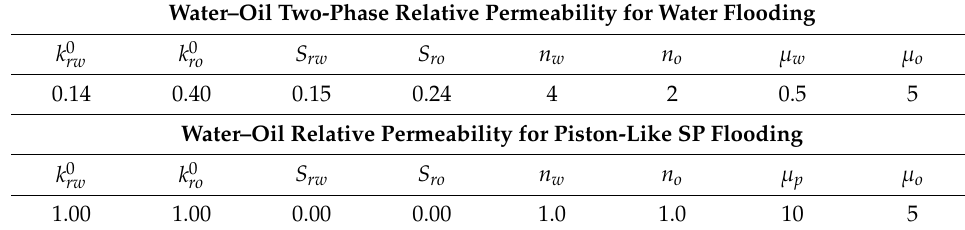
Figure 24. ( a ) Water–oil two-phase relative permeability for water flooding and piston-like displacement; ( b ) Construction of shock front for water flooding and piston displacement; ( c ) Water saturation profile at t D = 0.2 PV for piston-like SP flooding; and ( d ) Cumulative oil recovery during piston-like SP flooding. Table 5. Corey model parameters for water flooding and piston-like displacement in the presence of surfactant /